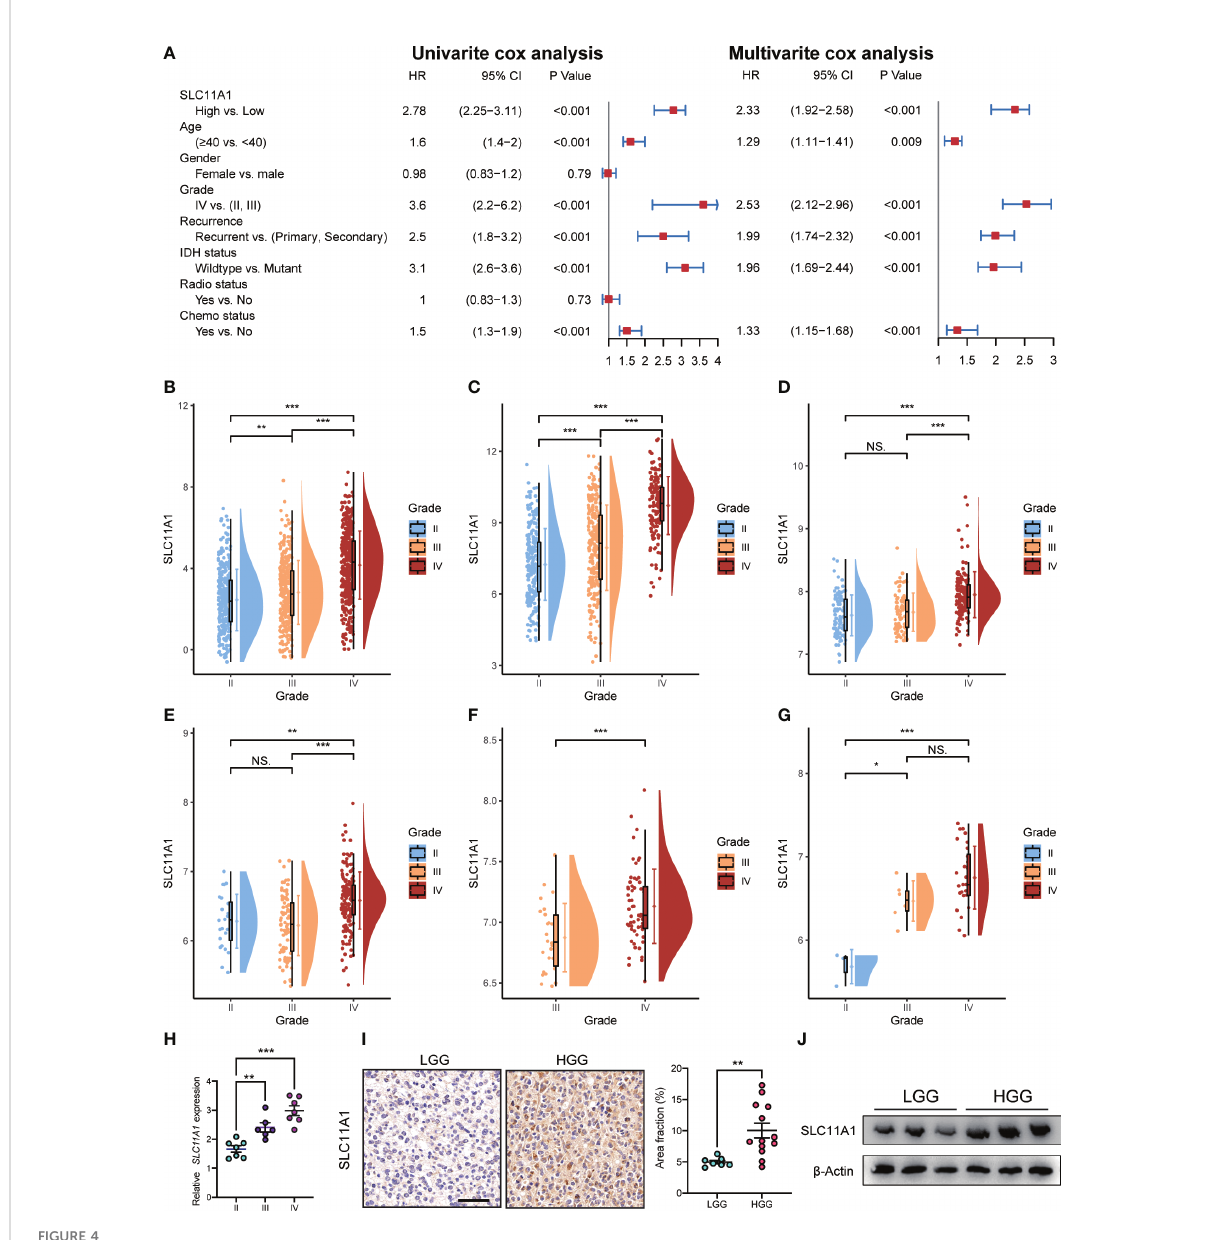
FIGURE 4 Expression of SLC11A1 increased with the progression of glioma. (A) Univariate and multivariate analysis for overall survival of glioma patients. (B) CGGA, (C) TCGA, (D) Rembrandt, (E) GSE16011, (F) GSE4412, and (G) GSE43289. (The X-axis represents the WHO grade while the Y-axis represents SLC11A1 expression value (log2). Based on Wilcoxon test.) (H) qRT-PCR of SLC11A1 of 20 patients with gliomas. (I) Representations and quanti fi cation of immunohistochemistry detection of SLC11A1 in LGG (low grade glioma) and HGG (high grade glioma). *,P < 0.05; **,P < 0.01; ***,P < 0.001, ns = no signi fi cance (Wilcoxon test). (J) Western blot of SLC11A1 in LGG (low grade glioma) and HGG (high grade